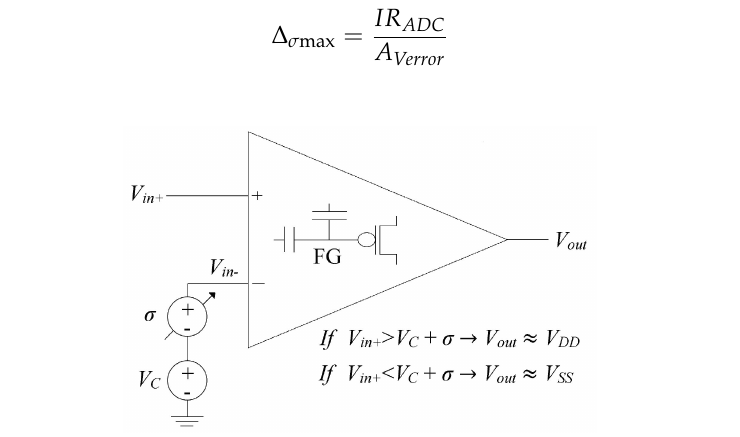
Figure 7. The POOA as a voltage comparator. To implement a voltage comparator, the POOA should be connected in an open loop topology and the inverted input ( V in − ) should be taken to V C . The input referred offset voltage behaves as a DC power supply inserted into the V in+ path, so that the comparator decision level depends on the offset voltage.